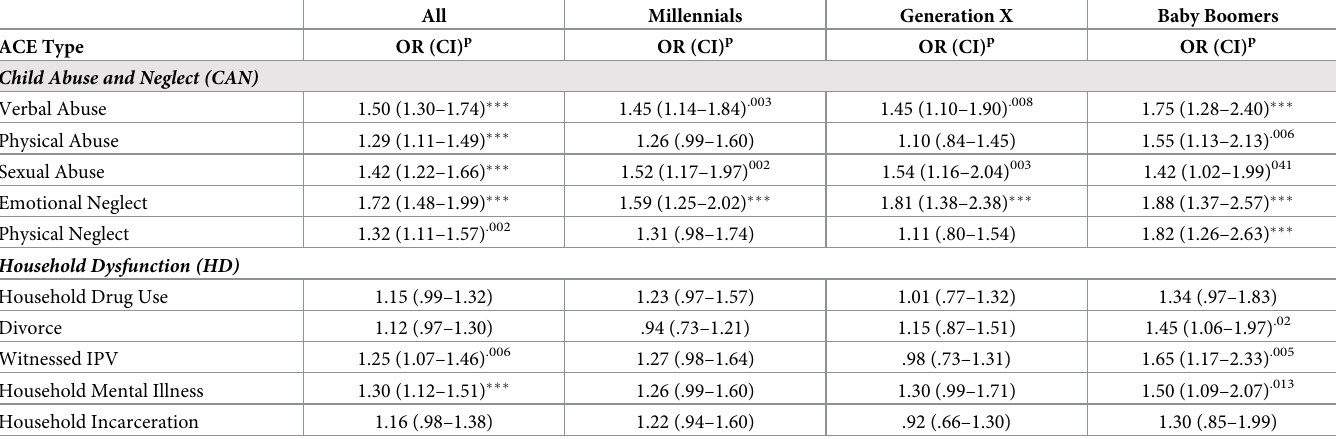
Table 2. Adjusted odds between ACE type and suicidal ideation a . All Millennials Generation X Baby